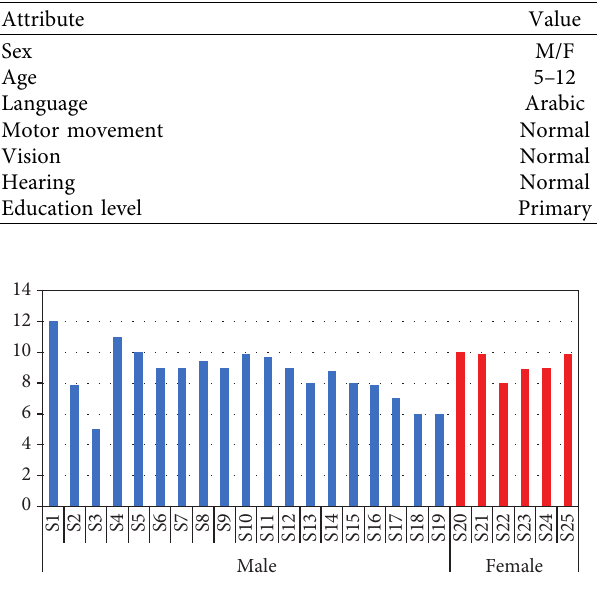
Figure 7: Word cloud representation of responses indicating el- ements in need of improvement in the